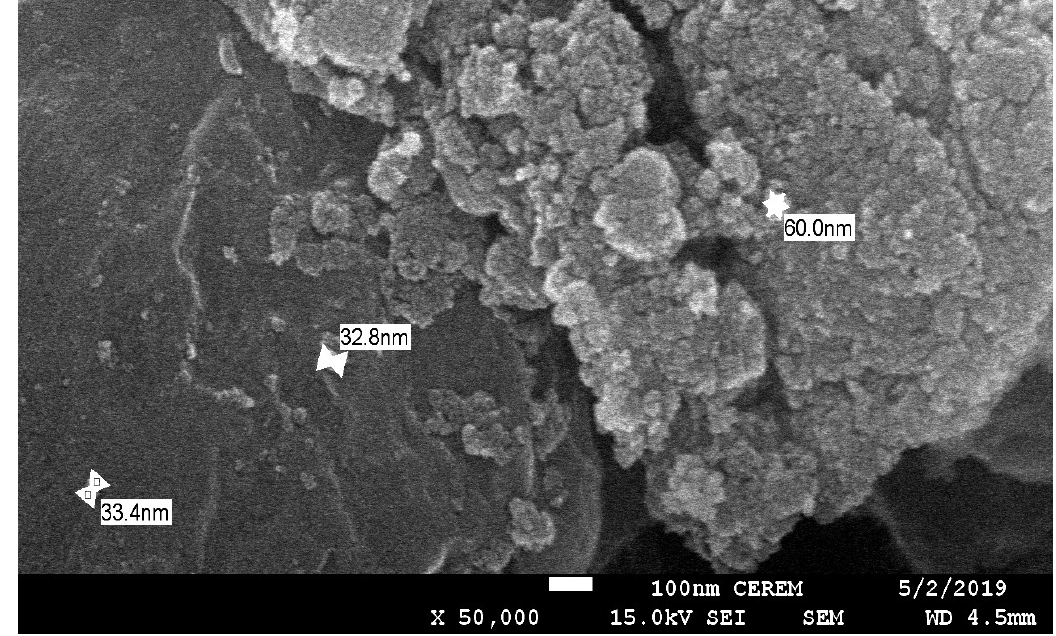
Figure 1. Scanning electron micrograph of treated palm leaves (Magnification = 50,000×).